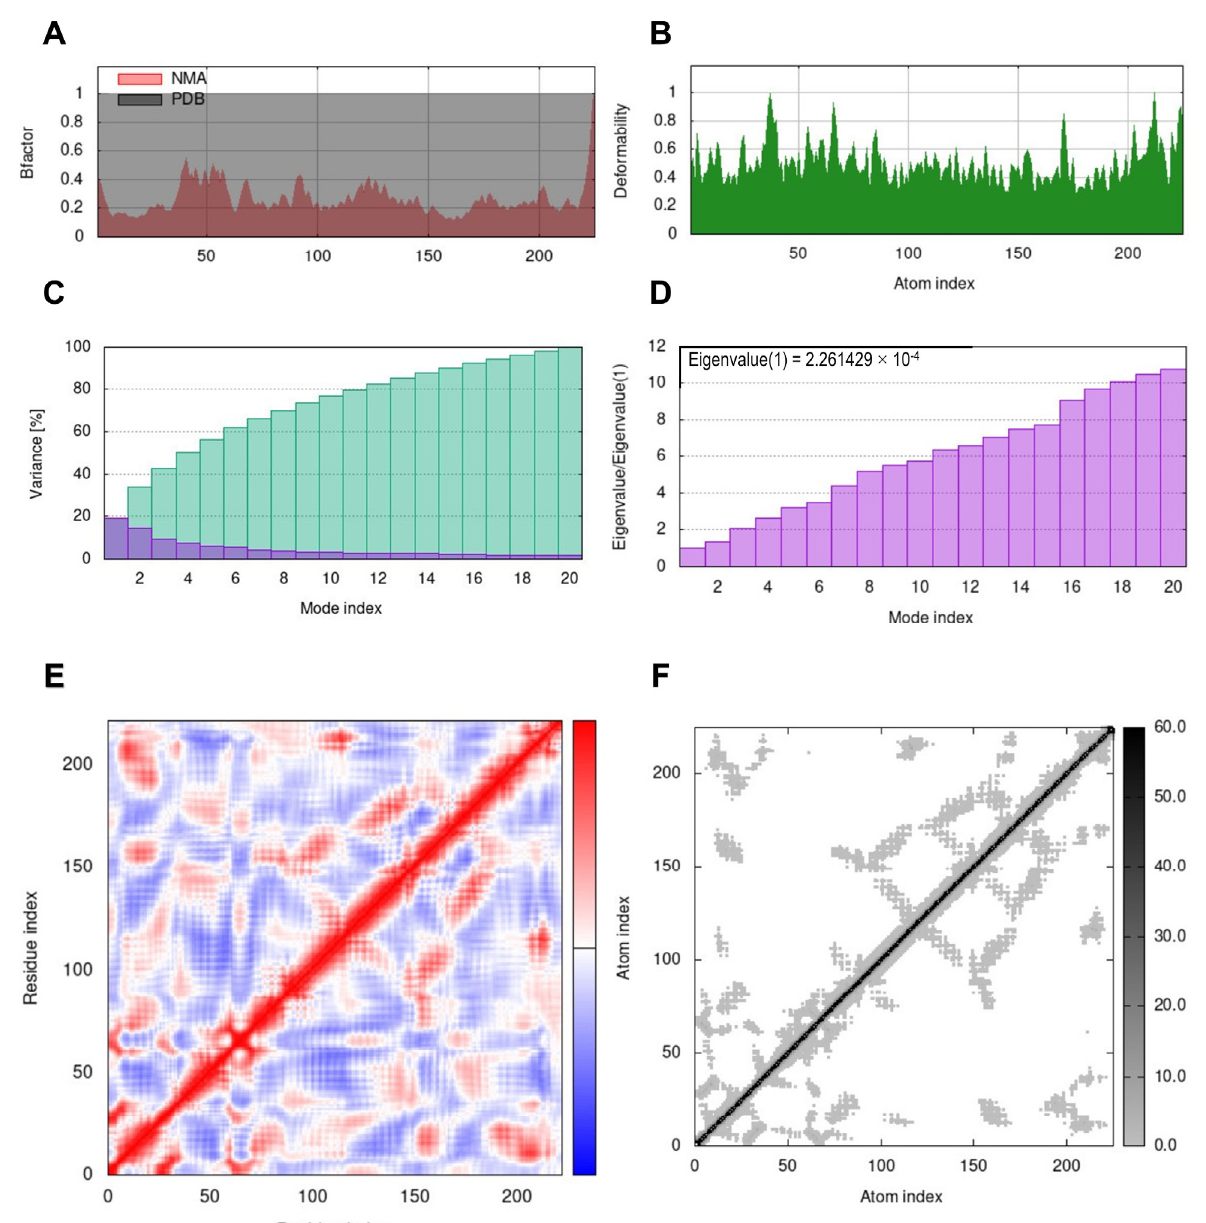
Figure 5. Result outputs of the normal mode analysis (NMA) through the iMODs server. ( A ) factor; ( B ) deformation plot; ( C ) variance plot; ( D ) eigenvalue; ( E ) covariance matrix plot; ( F ) elastic network